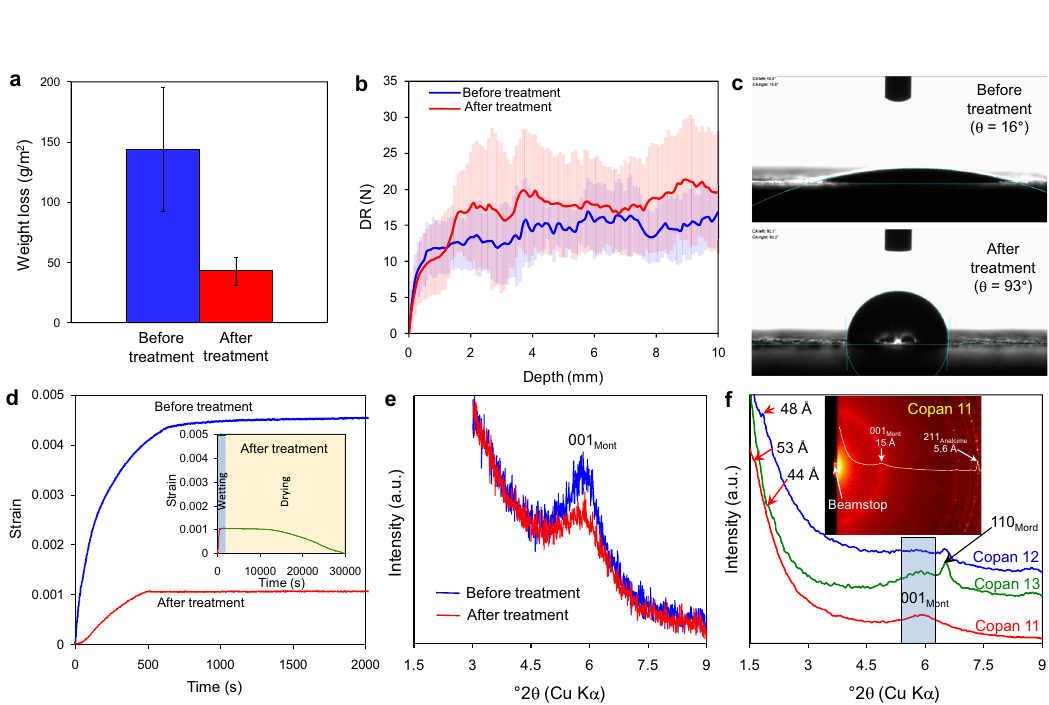
Fig. 6 Evaluation of the treatment ’ s performance. a Results of the peeling tape test before and 3 months after in situ treatment. Average values ( N = 12) and standard deviations are represented. b Drilling resistance (DR) along a depth pro fi le of Copan stone before and 3 months after ex situ treatment. Average DR values ( N = 9) and standard deviations (shaded areas) are represented. c Representative examples of water contact angle of Copan stone before and after bacterial treatment. d Free swelling strain of Copan stone (Type 3) upon immersion in water. A reduction in maximum strain is observed after bacterial treatment. The inset shows a full wetting/drying cycle of the treated Copan stone. Note the absence of residual strains after complete drying. e Conventional XRD pattern of untreated and bacterially treated Copan stone showing a reduction in the intensity of the 001 Bragg peak of montmorillonite (Mont). f Small-angle XRD patterns of treated Copan stones (samples Copan 11 – 13). The red arrows point to peaks and shoulders at d -spacings of 45 – 53 Å. The blue-shaded area shows the broad 001 Bragg peak of montmorillonite (Mont). The 110 Bragg peak of mordenite (Mord) is indicated. The inset shows the 2D diffraction pattern of sample Copan 11, including the radially integrated line